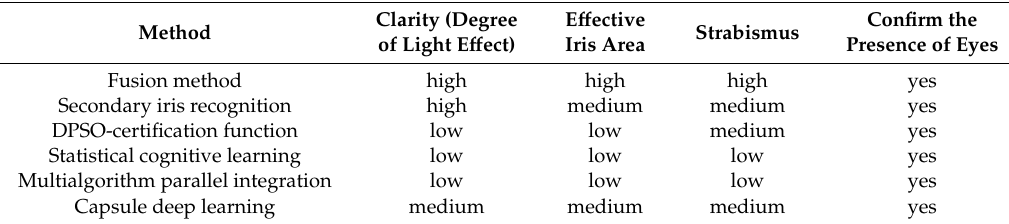
Table 2. The degree of quality requirements of the iris indicators of each algorithm.